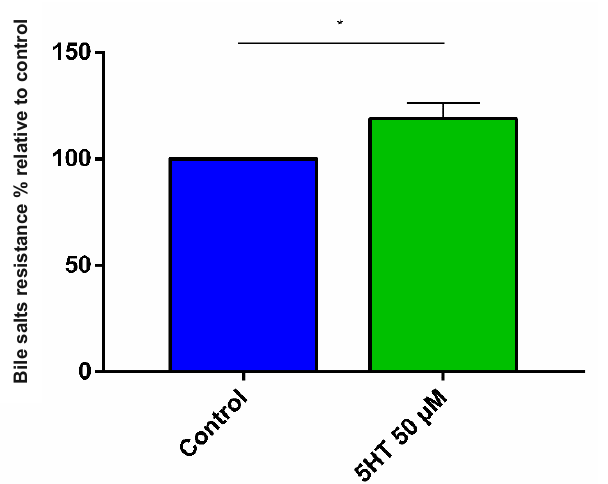
Figure 2. Bile salt resistance. Bile salts (4.5%) tolerance of E. faecium NCIMB10415 is expressed as % of control and is increased after a pre-treatment with 50 µ M 5HT (* p < 0.05).